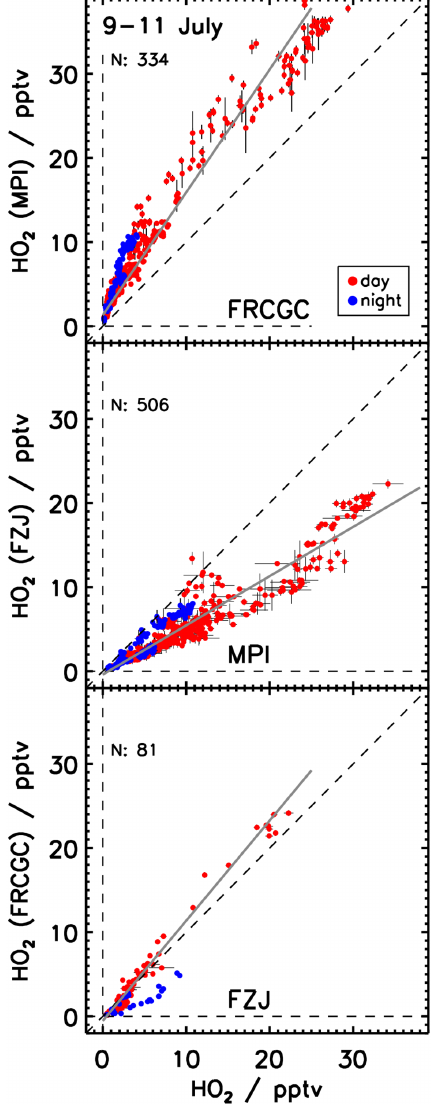
Fig. 8. Correlation of HO 2 mixing ratios in ambient air on 9–11 July (1min average). The dashed line is the 1:1 line. The solid lines result of linear fits to the daytime data, only. The scatter of the entire data sets is larger than expected from the precision of single data points.